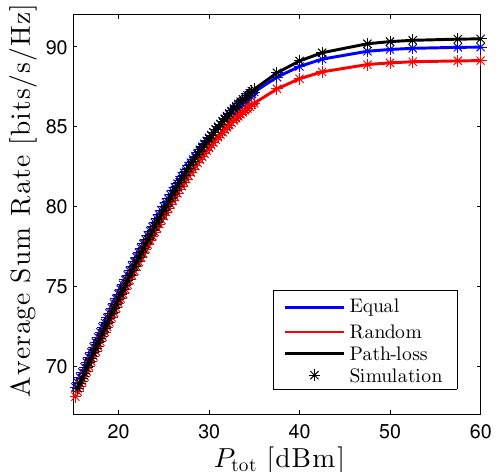
Figure 8. Average Sum Rate of D2D networks vs. P tot under three power allocation methods. Solid lines are plotted by employing (16) and markers are Monte Carlo